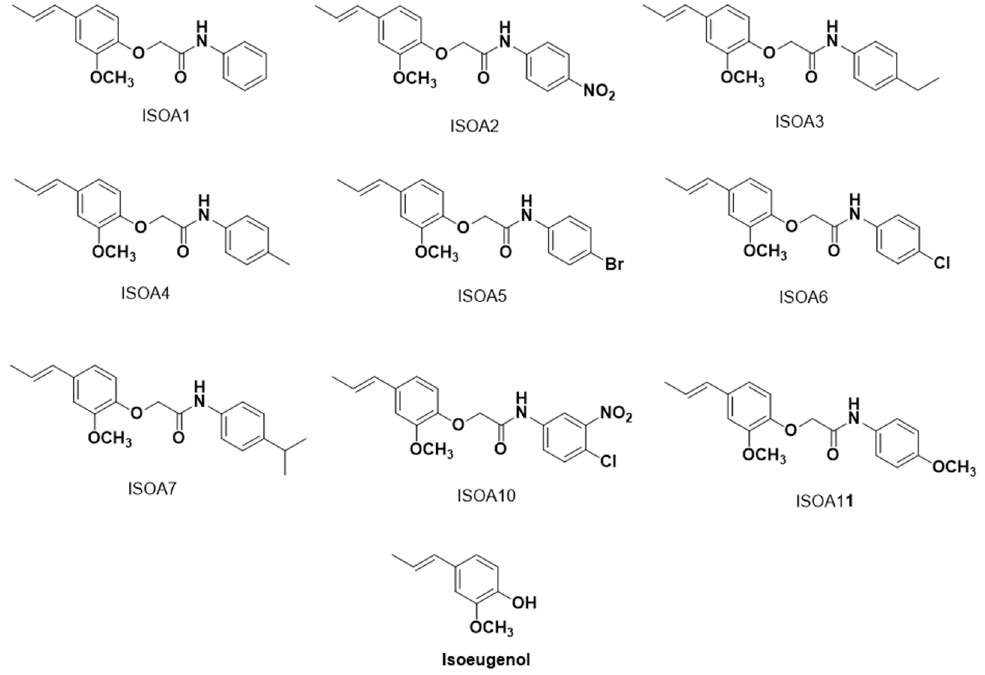
Figure 4. Chemical structures of hybrid acetamides derived from isoeugenol (ISO A1–ISO A11) and isoeugenol.